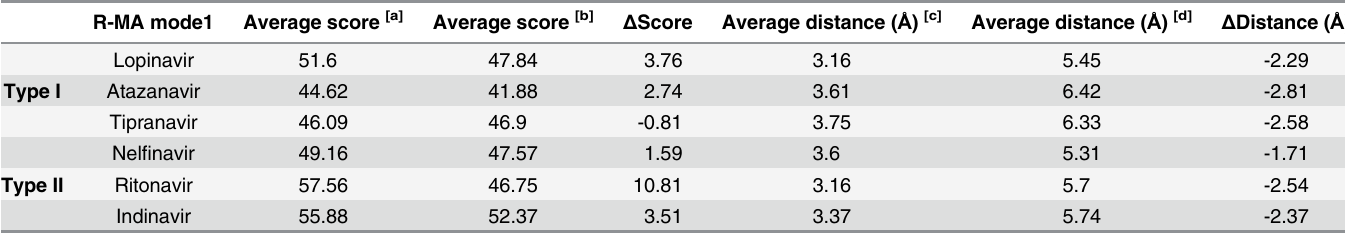
Table 3. The statistical results of PIs docking into CYP3A4 active site in the presence of methamphetamine. R-MA